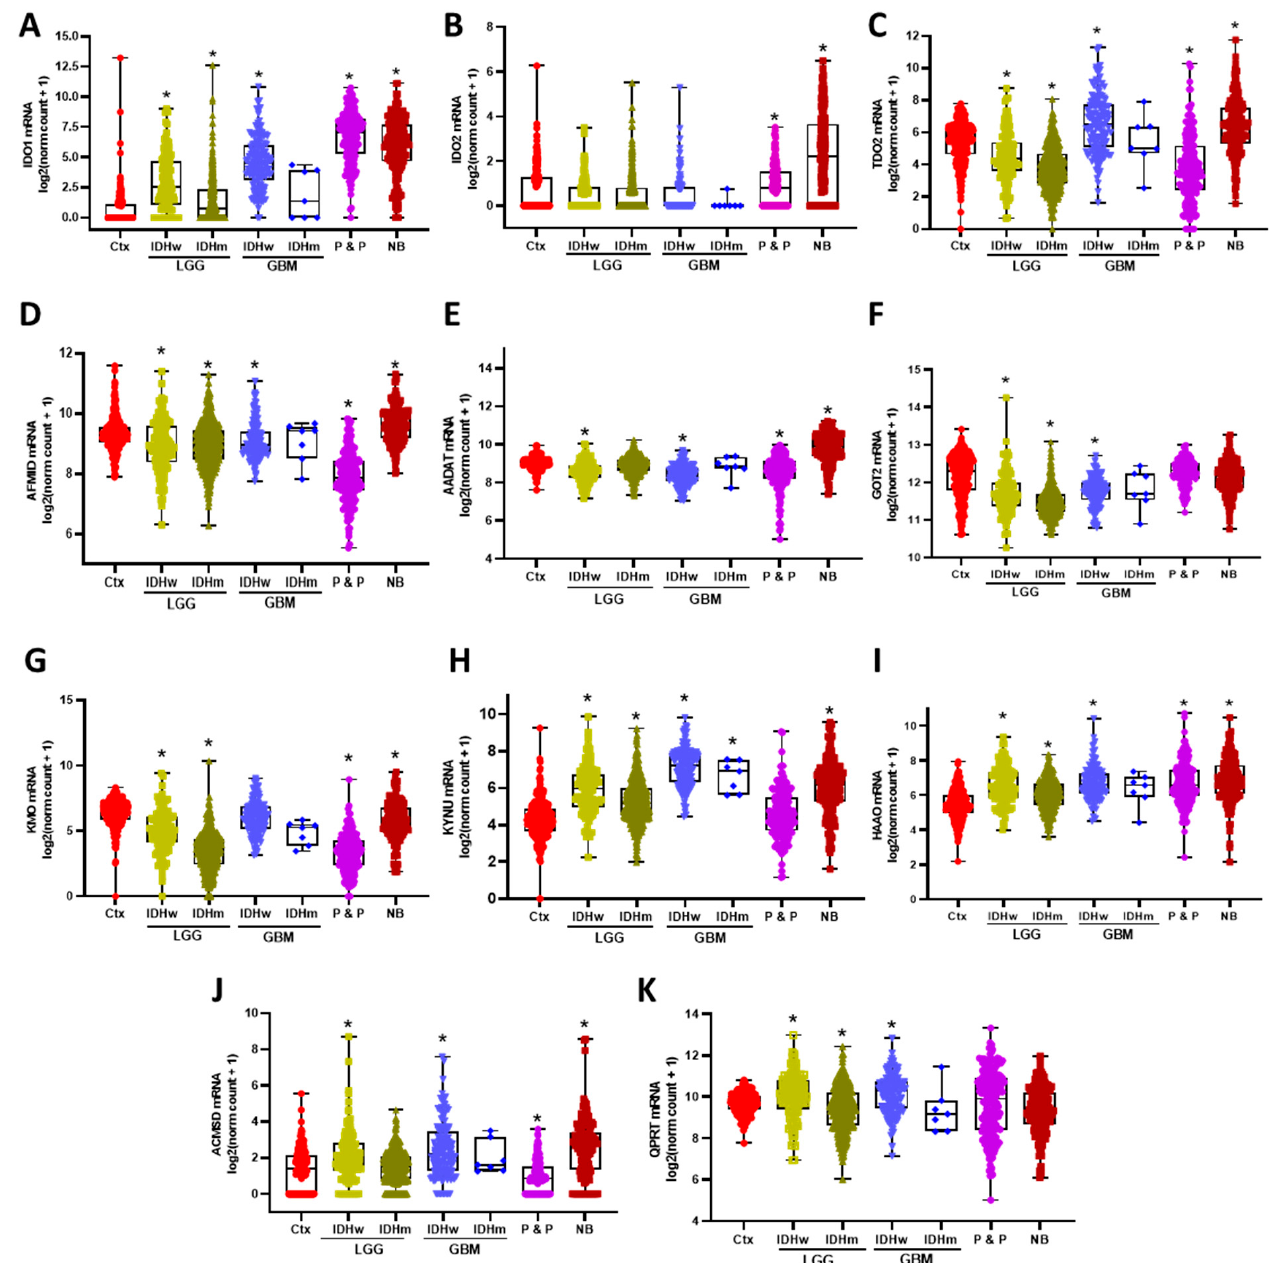
Figure 1. Differential gene expression of the KP enzymes among brain tumors. Low grade gliomas (LGG) and glioblastoma (GBM) were separated according to their IDH wildtype (IDHw) or IDH mutant (IDHm) status, then expression levels of the KP enzymes IDO1 ( A ), IDO2 ( B ), TDO2 ( C ), AFMID ( D ), AADATnaïve ( E ), GOT2 ( F ), KMO ( G ), KYNU ( H ), HAAO ( I ), ACMSD ( J ), and QPRT ( K ) were compared with non-tumor brain cortex samples (Ctx), pheochromocytomas and paragangliomas (P & P), and neuroblastomas (NB). * p < 0.05 when considering the Dunn’s test for multiple pairwise comparisons against